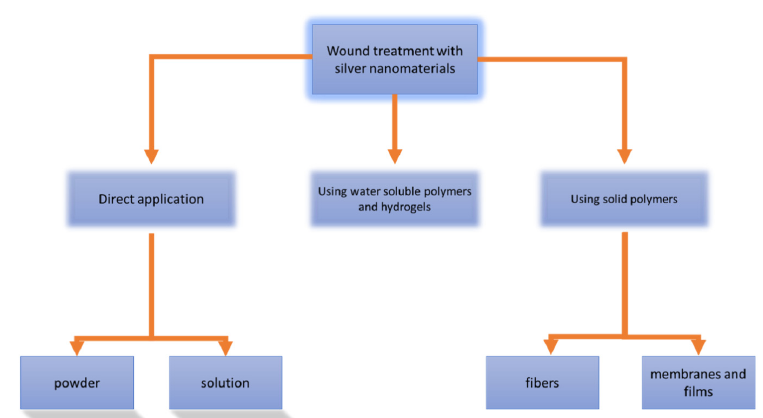
Figure 3. Two basic methods of screening of the antibacterial effect: ( A ) Effect of AgNPs in concentrations of 5 (1), 2.5 (2), 1.25 (3) and 0.625 mg/mL (4) in the agar plate disk diffusion test on S. aureus cells after 24 h of incubation. Growth inhibition zones are marked by red circles. ( B ) The growth curve of S. aureus without (control) or with 0.1 mg/mL AgNPs showed optical density of 620 nm (OD 620 ), dependent on the time of growth.